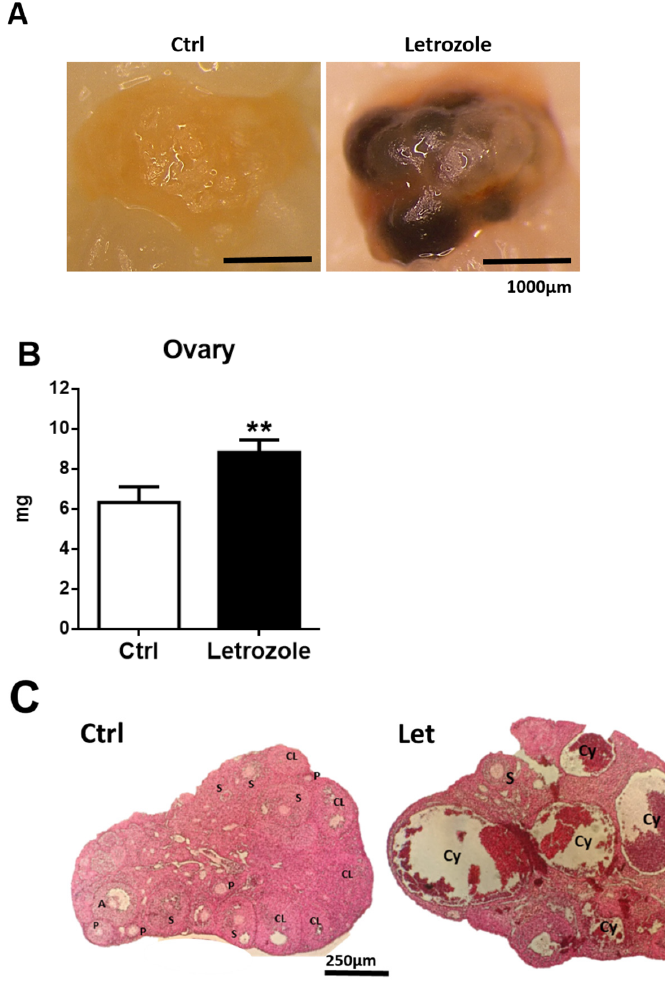
Figure 3. After 20 weeks of oral feeding with letrozole, the letrozole-treated mice showed some vis- ible cysts on the surface of the ovaries, as shown in ( A ). The ovarian weight in the letrozole-treated mice is significantly higher than in control mice ( B ). The micromorphology of the ovaries was ob- served following hematoxylin and eosin (H&E) staining (C). The magnification is 40× and the scale bar = 250 μ m. The ovary from a control mouse shows normal ovarian follicles (P—primary follicles; S—secondary follicles; A—antral follicles) and CL. The ovary from a letrozole-treated mouse shows cystic follicles (Cy) and the absence of the CL. ** p < 0.01, compared with the control mice.